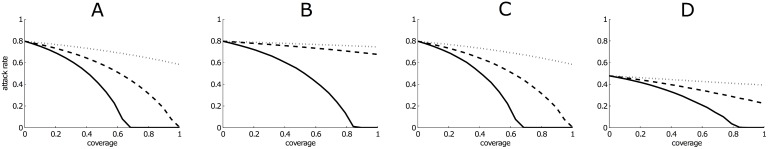
Attack rate with coverage for scenarios A-D.Predicted attack rates for four different pandemic and vaccine action scenarios as a function of general population coverage with a CTL-inducing vaccine. In each panel the solid line corresponds to assumptions of relative infectiousness in vaccinated and unvaccinated naïve hosts of ϵ
v = 0.25, with dashed and dotted lines corresponding to ϵ
v = 0.5 and 0.75 respectively. Scenario A captures a population without pre-existing CTL-mediated immunity to the pandemic strain. In scenarios B and C, 80 per cent of the population have pre-existing CTL-mediated immunity (f
E = 0.8) suppressing infectiousness by 50 per cent (ϵ = 0.5), with vaccine action saturating (B) or boosting (C). Scenario D is a modification of scenario C that assumes 50 per cent of those with naturally acquired CTL immunity also have cross-reactive protective antibody.